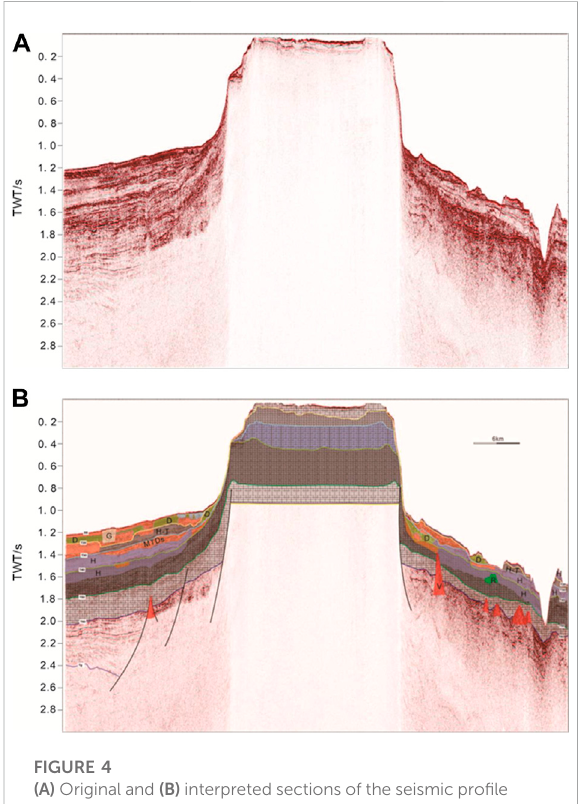
FIGURE 5 (A) Original and (B) interpreted sections of the seismic pro fi le